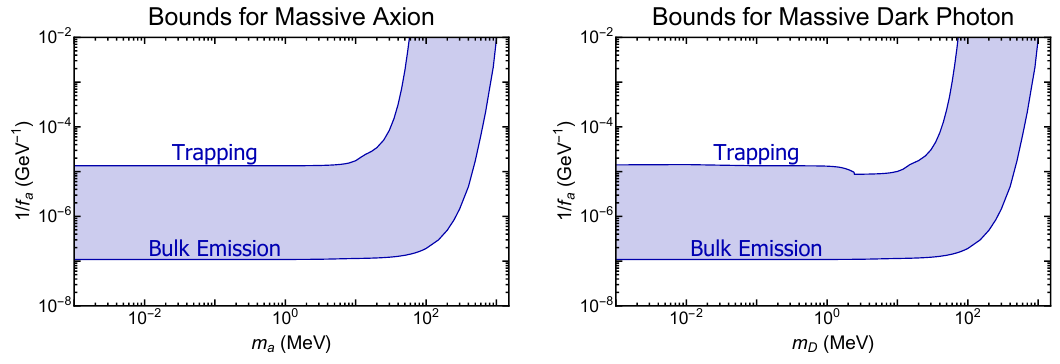
Figure 5 . These plots show the lower constraint from bulk emission and the upper constraint from trapping as a function of particle mass. The first plot shows these constraints for a massive axion and massless dark photon and the second plot shows them for a massive dark photon and a massless axion. Note that the upper trapping limit only contains the contributions from trapped axions and transverse dark photons since we must treat the longitudinal dark photons separately (see section